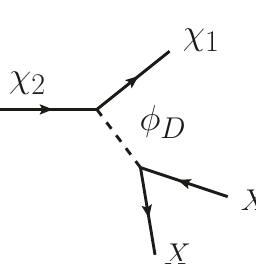
Figure 2 . Topology for the decay of (cid:31) 2 into (cid:31) 1 and SM particles ( X ) through a light mediator (cid:30) D .